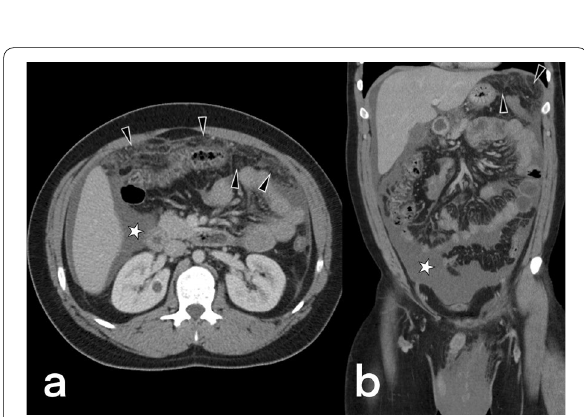
Fig. 26 A 24-year-old male patient. Axial ( a ) and coronal postcontrast CT ( b ) images show mesenteric striation (arrowheads) and ascites (star)